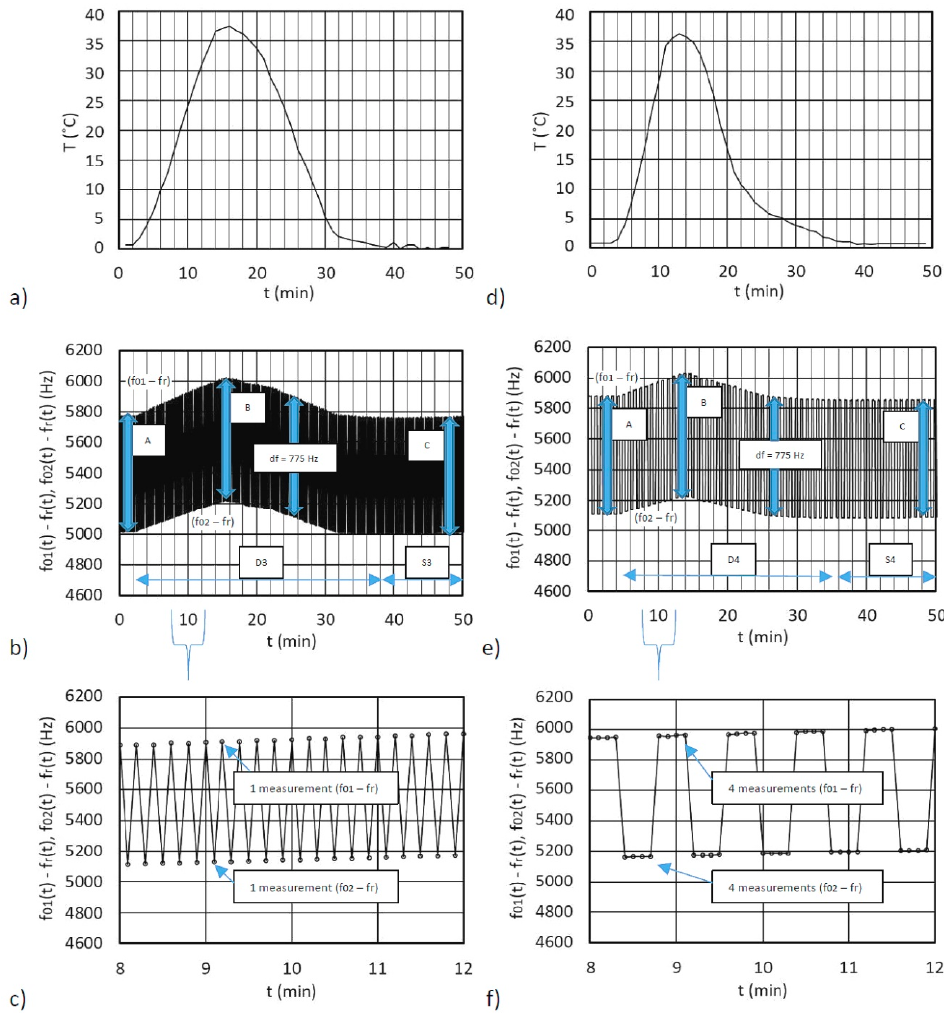
Figure 7. ( a , d ) Dynamic temperature change from 0 ◦ C to 40 ◦ C and back to 0 ◦ C, ( b , e ) The change of the output frequency di ff erences ( f 01 (t) − f r (t)) and ( f 02 (t) − f r (t)) during the temperature change, ( c ) The zoomed interval (Figure 7b) between eight and 12 minutes for one measurement of frequency di ff erences ( f 01 (t) − f r (t)) and ( f 02 (t) − f r (t)) ( f ) The zoomed interval (Figure 7e) between 8 and 12 minutes for four measurements of frequency di ff erences ( f 01 (t) − f r (t)) and ( f 02 (t) − f r (t)).